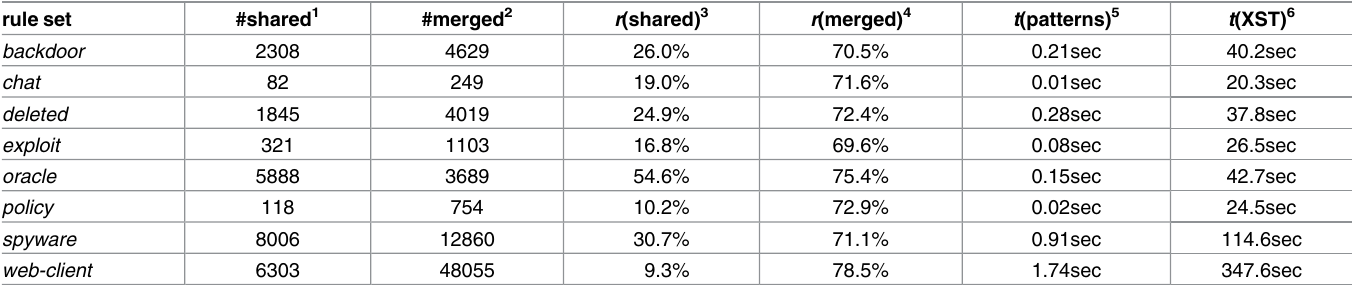
Table 2. Evaluation data with proposed string matching